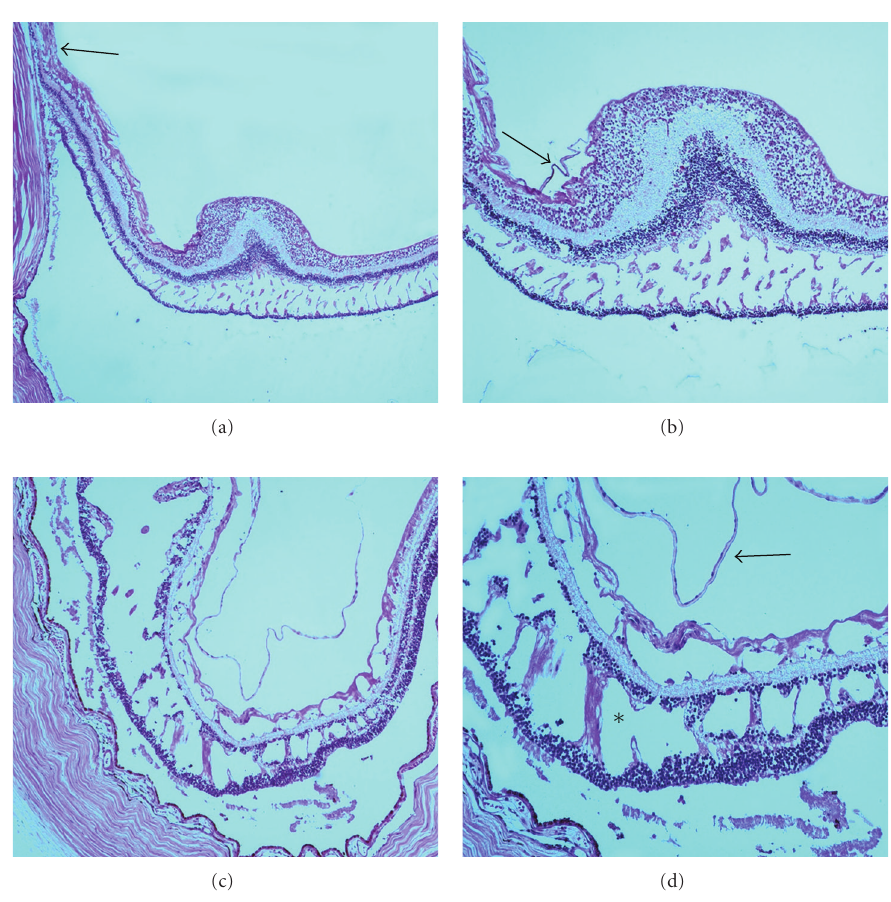
Figure 2: (a) Photomicrograph of the right eye demonstrating areas of macular foveoschisis. A region containing the staphyloma is also seen (black arrow). (b) Higher magnification of macular foveoschisis seen in multiple layers of the retina including the outer plexiform layer, inner plexiform layer, nerve fiber layer, and the outer plexiform layer in the perifoveal region. A thin fibrous preretinal membrane is seen (black arrow). (hematoxylin and eosin, original magnification, (a) x50; (b) x100). (c) Photomicrograph of the left eye demonstrating classical retinoschisis in the outer plexiform layer, ganglion cell layer, and nerve fiber layer. (d) Higher magnification demonstrating neuronal bridges between both nuclear layers (asterisk). A fibrous preretinal membrane is seen (black arrow). (hematoxylin and eosin, original magnification, (a) x50; (b)